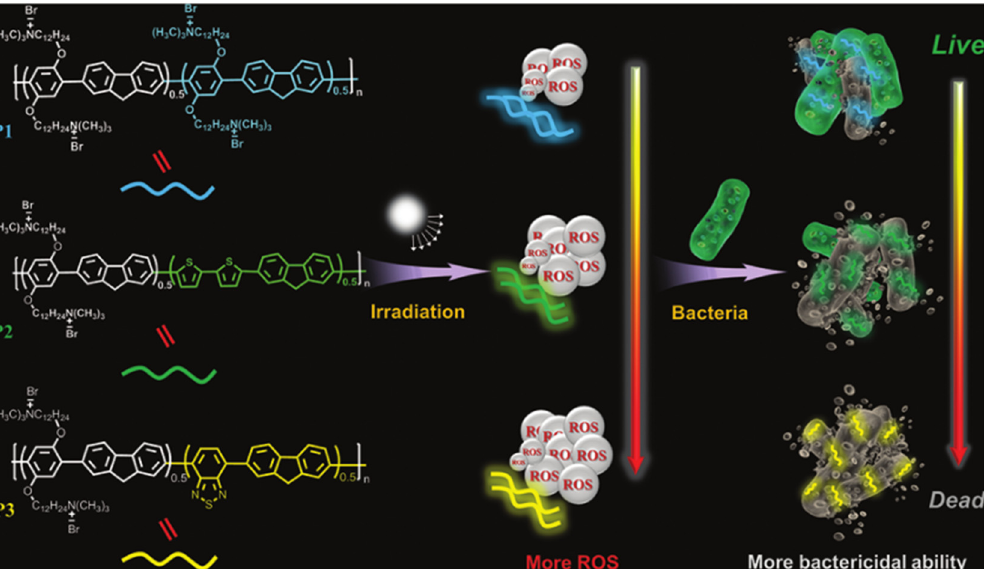
Figure 16. Schematic diagram of chemical structure and antimicrobial activity of P1-P3. Reproduced from Ref. [60] with permission from the Royal Society of Chemistry.